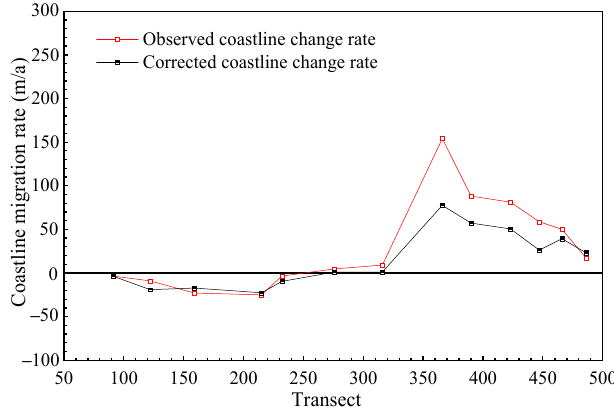
Figure 8. Validation of algorithm results.